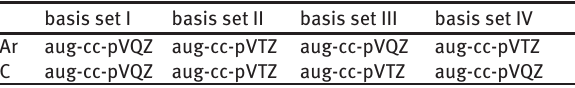
Table 1: Four different basis sets